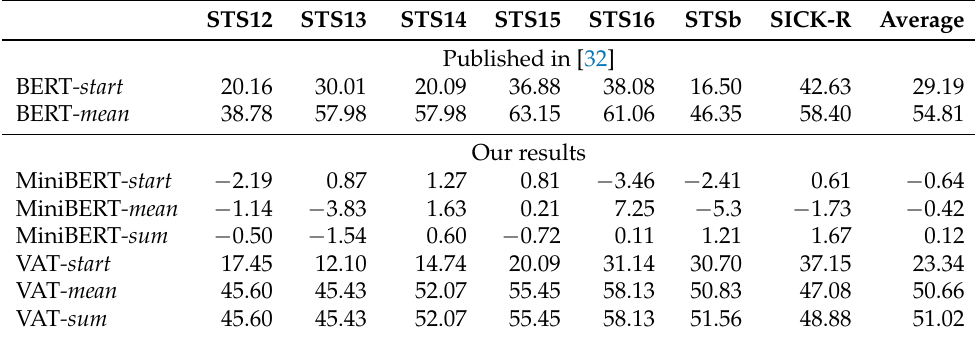
Table 4. Spearman rank correlation between the cosine similarity of sentence representations and gold label similarity for different Semantic Textual Similarity (STS) tasks without fine-tuning the underlying models to the target